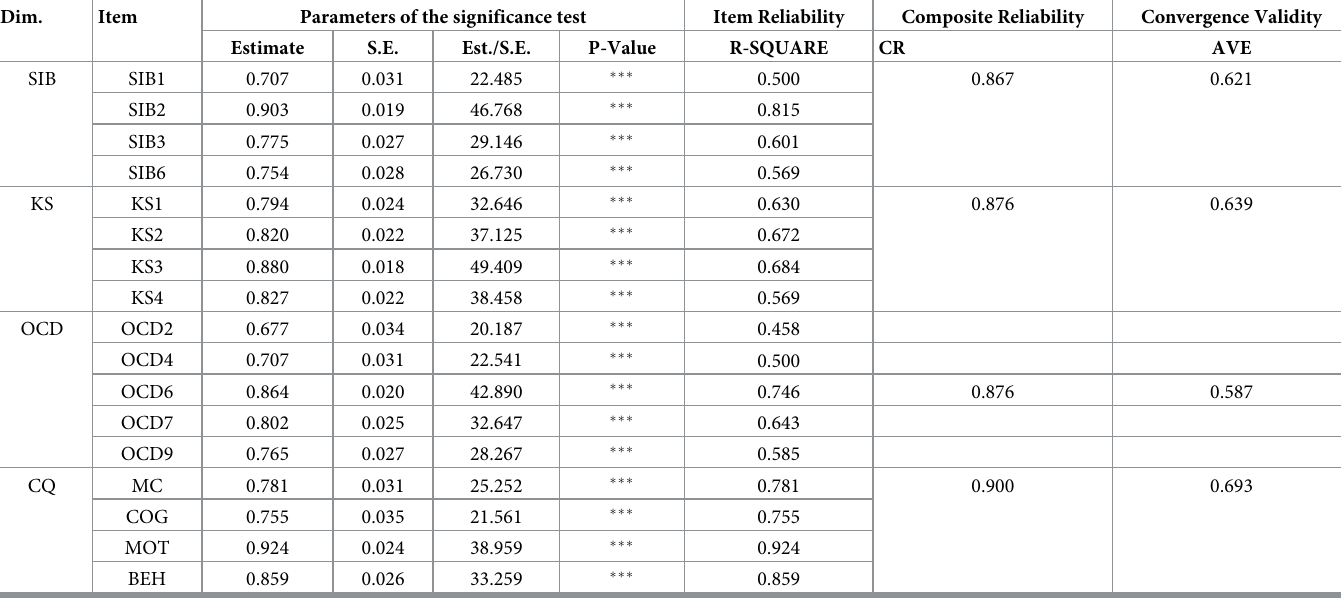
Table 2. CR & AVE. Dim.